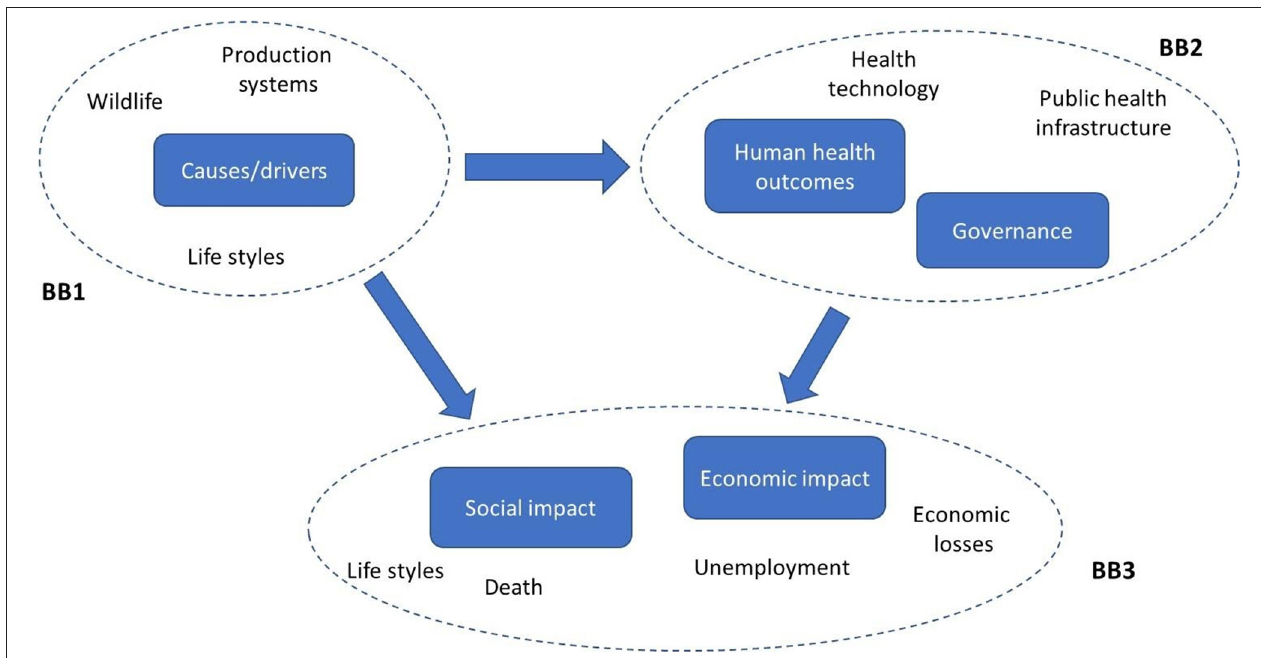
FIGURE 1 | Building blocks in systems thinking for COVID-19 like